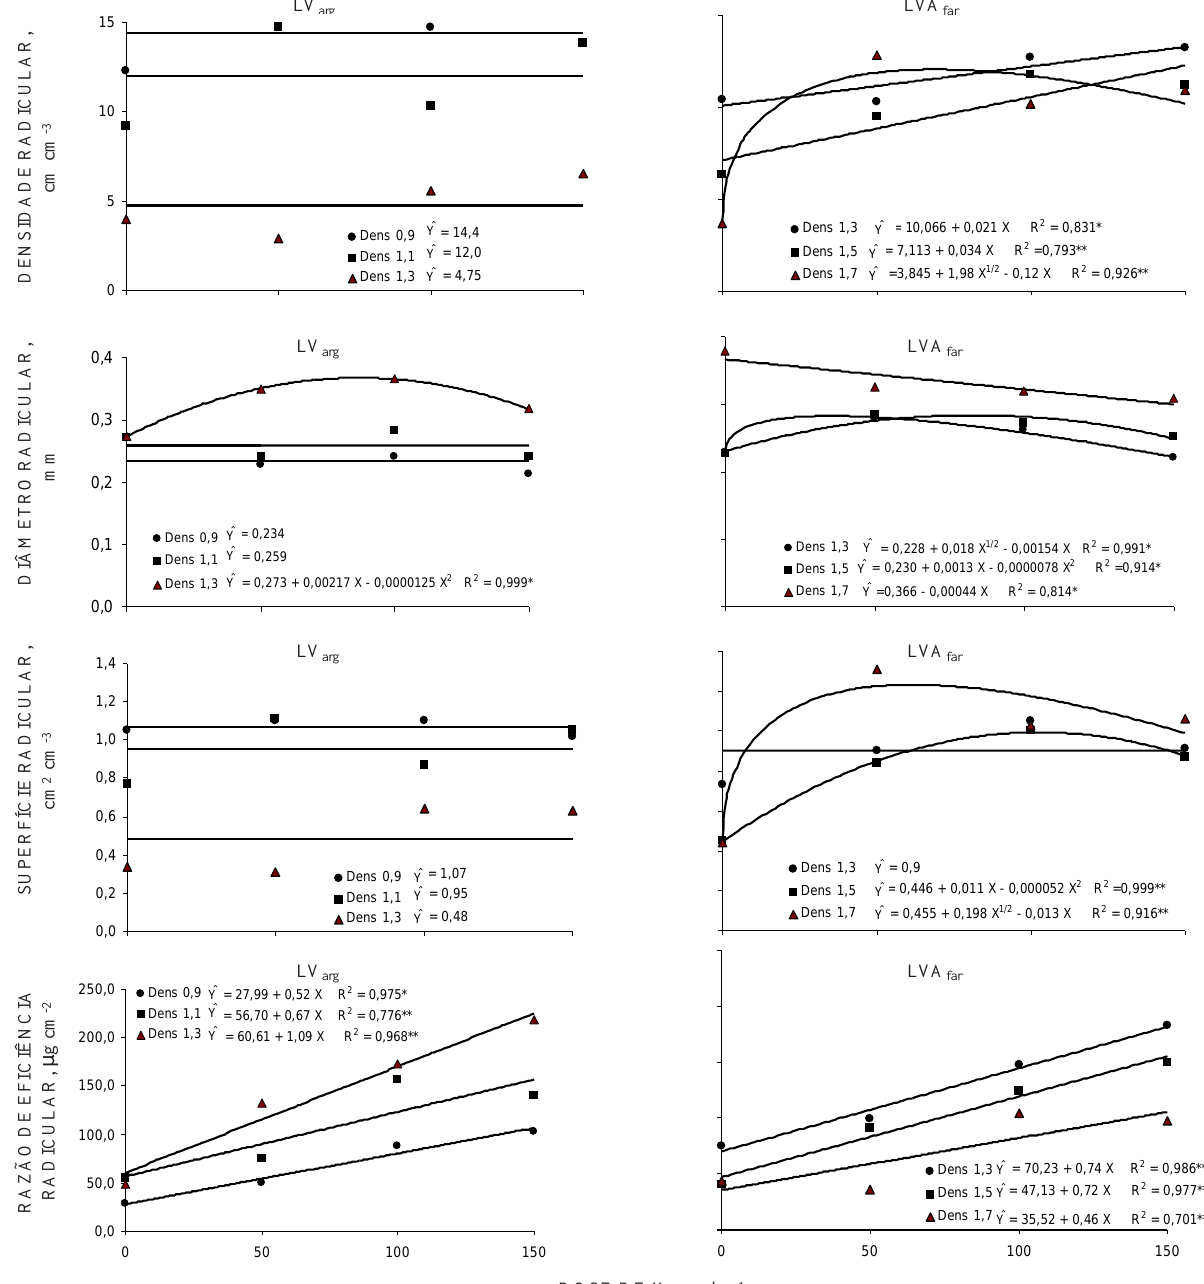
DOSE DE K, mg kg